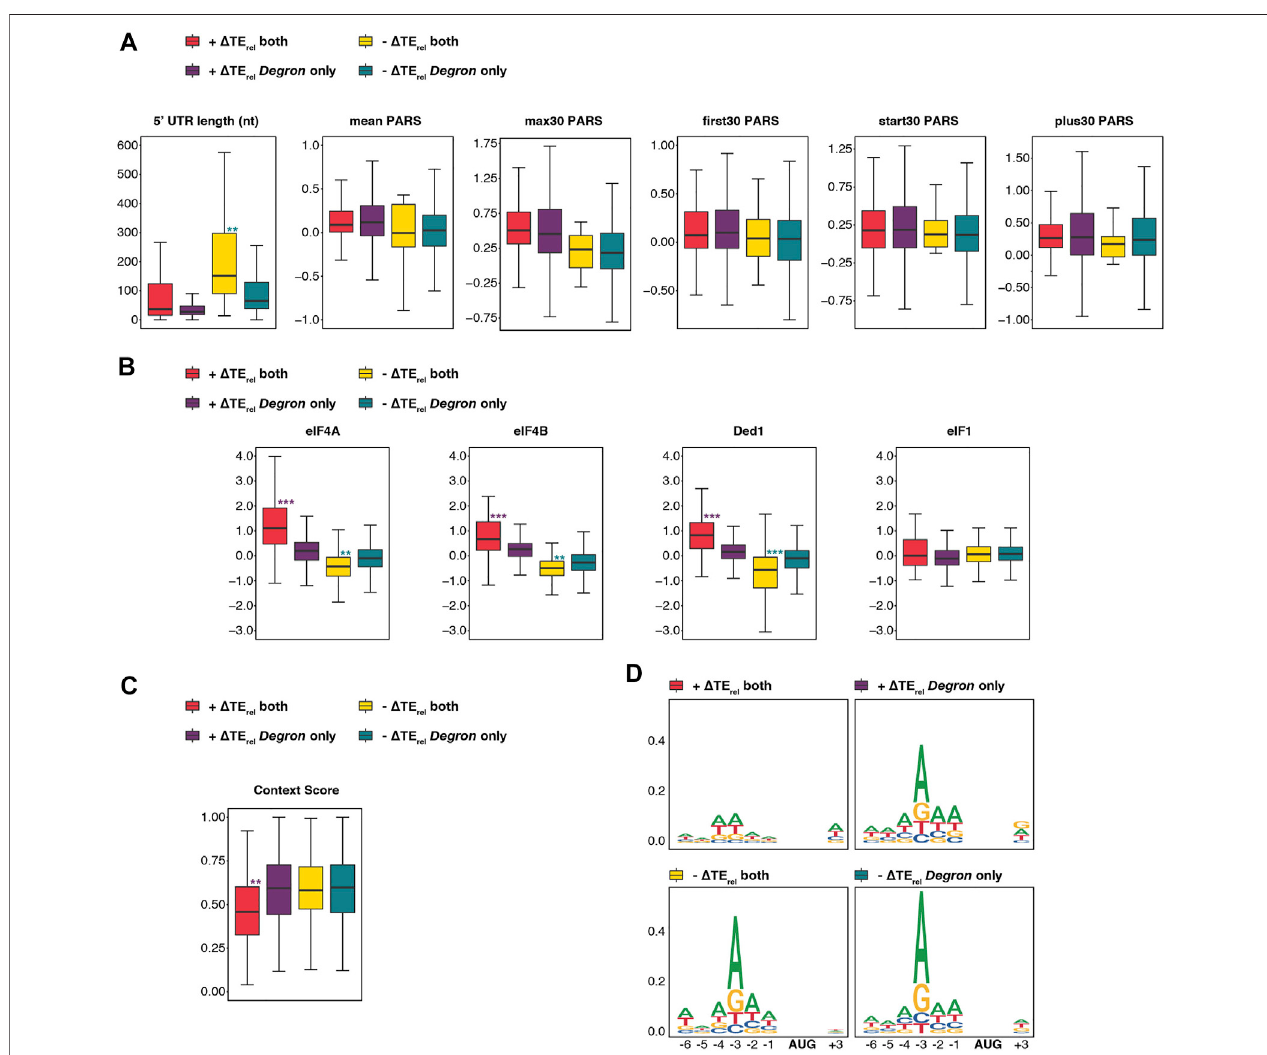
FIGURE6| TheeIF3mRNA-entry-channelarmcollaborateswitheIF4A,eIF4B,andDed1todriveinitiationonmRNAswithlong5 ′ -UTRsandmayalsodiscriminate against poor start-codon context. (A) Box and whisker plots comparing different measures of 5 ′ -UTR length or complexity between mRNAs whose TE rel signi fi cantly increasesordecreasesinboth eIF3a/bDegron and eIF3iDDKK cells(redandyellow,respectively)orincreasesordecreasesonlyin eIF3a/bDegron cells(purpleandteal, respectively).*** (cid:1) P adj < 10 − 10 ,** (cid:1) P adj < 10 − 5 ,* (cid:1) P adj < 0.05,colorindicatescomparisonset;WilcoxonTestfor5 ′ -UTRlengths,ANOVAwithpost-hocTukeytest forothers. (B) SameasinA,exceptcomparing Δ TE rel valuesobservedincellsexpressingmutationstargetingeIF4A,eIF4B,Ded1,andeIF1.*** (cid:1) P adj < 10 − 10 ,** (cid:1) P adj < 10 − 5 ,* (cid:1) P adj < 0.05,colorindicatescomparisonset;ANOVAwithpost-hocTukeytest. (C) SameasinA,exceptcomparingtheKozaksequencecontext(nt-6thru+4)of affected mRNAs. *** (cid:1) P adj < 10 − 10 , ** (cid:1) P adj < 10 − 5 , * (cid:1) P adj < 0.05. (D) Sequence logos of nt -6 to +4 of mRNAs whose TE rel either increases (top panels) or decreases (bottom panels) in both eIF3a/b Degron and eIF3i DDKK cells (left panels) or only in eIF3a/b Degron cells (right